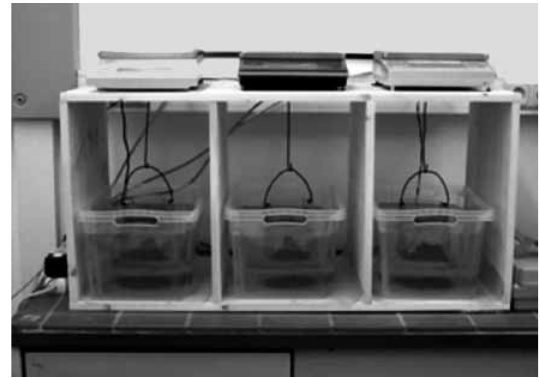
Fig. 3. Disintegration equipment after Weißmann